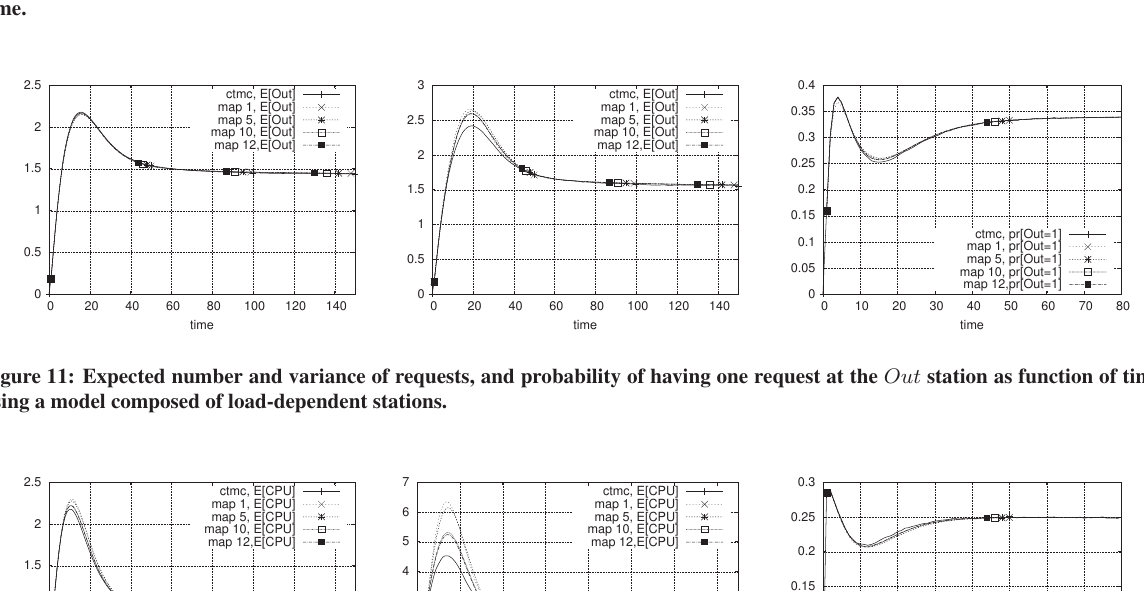
Figure 10: Expected number, variance of number of requests, probability of having one request at the CPU station as function of time.